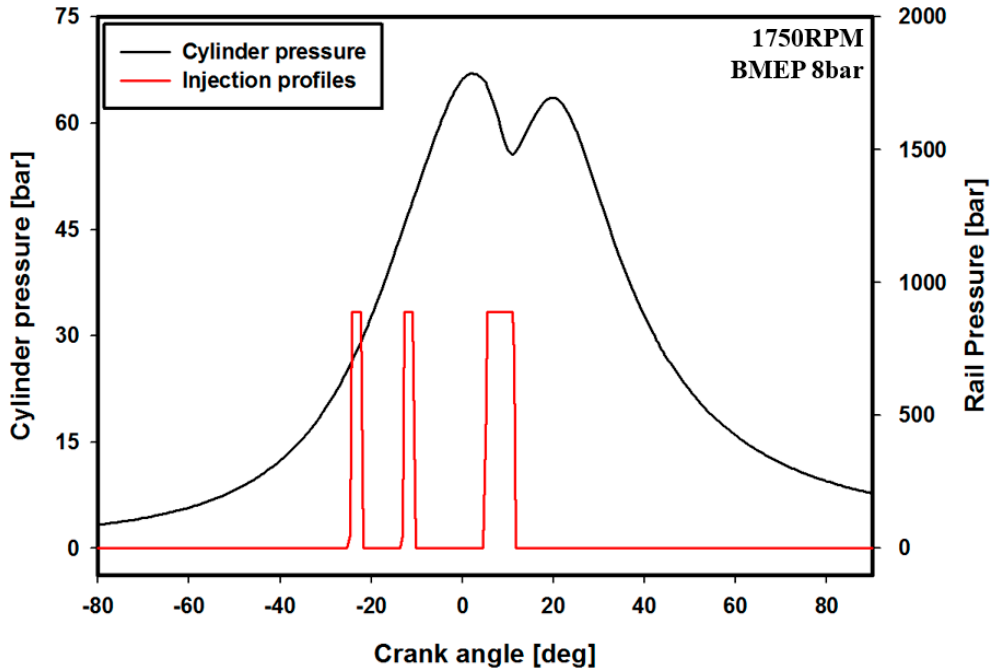
Figure 3. Calibrated in-cylinder pressure diagram with fuel injection using the direct-injection diesel multi-pulse (DI-pulse) combustion model.